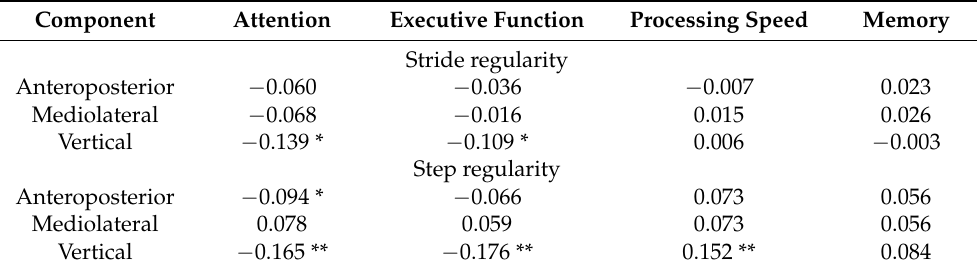
Table 3. Partial correlations after controlling the effect of age and gait velocity among gait regularity and cognitive domain function ( n = 463). Component